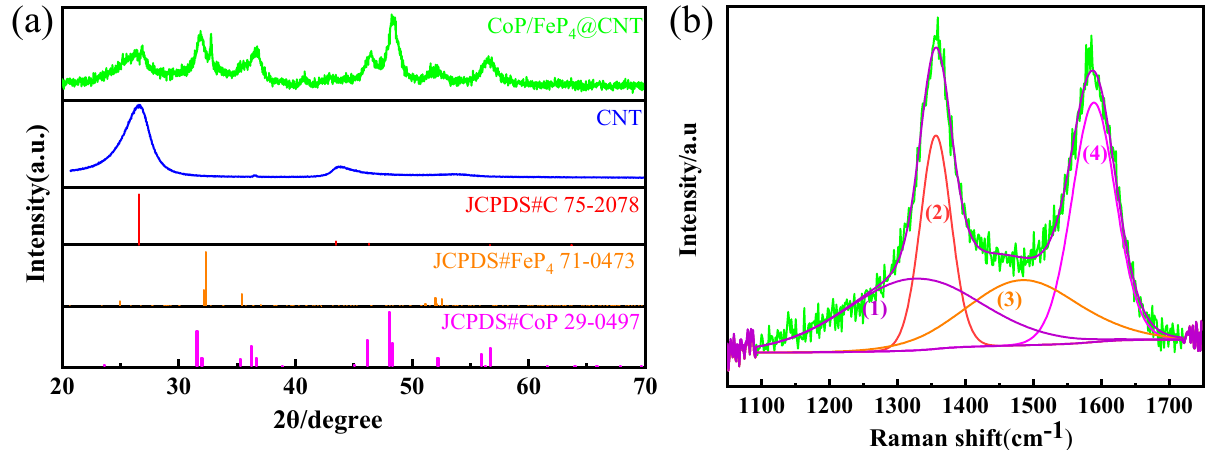
Figure 2. ( a ) The XRD pattern of the CoP/FeP 4 @CNT and CNT, ( b ) Raman spectrum of the CoP/FeP 4 @CNT.